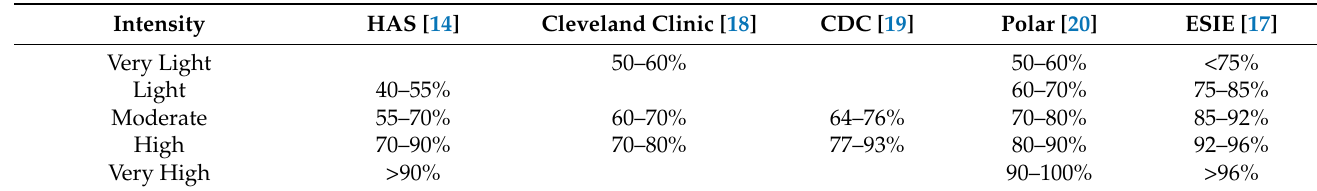
Table 2. Cardiac zones (by the percentage of the patient’s maximum heart